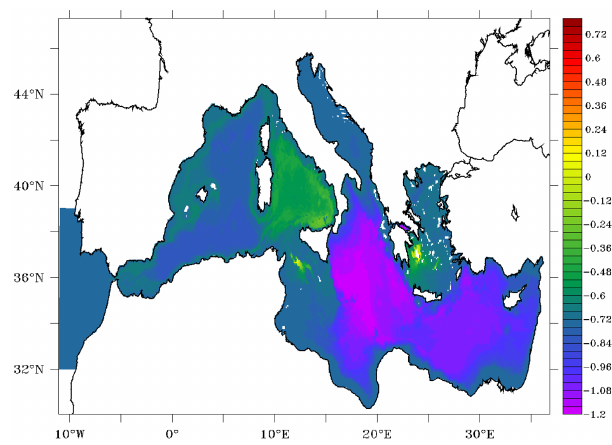
Figure 6. Horizontal distribution of δ 3 He mantle (%) (vertically av- eraged) across the Mediterranean